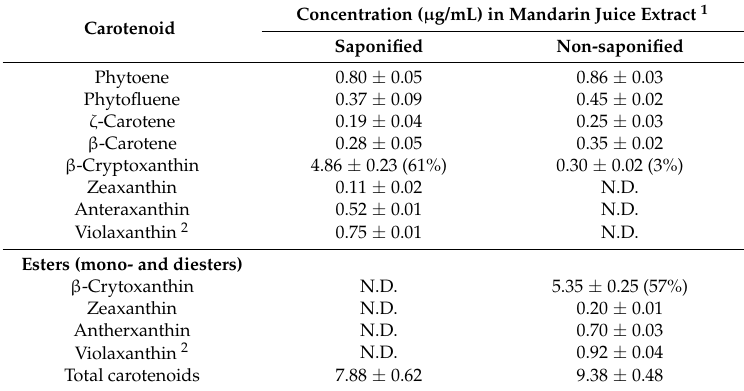
Table 1. Carotenoid content and composition in saponified and non-saponified juice extracts of Clementine mandarins. The percentage of β -Cryptoxanthin over the total amount of carotenoids is indicated in